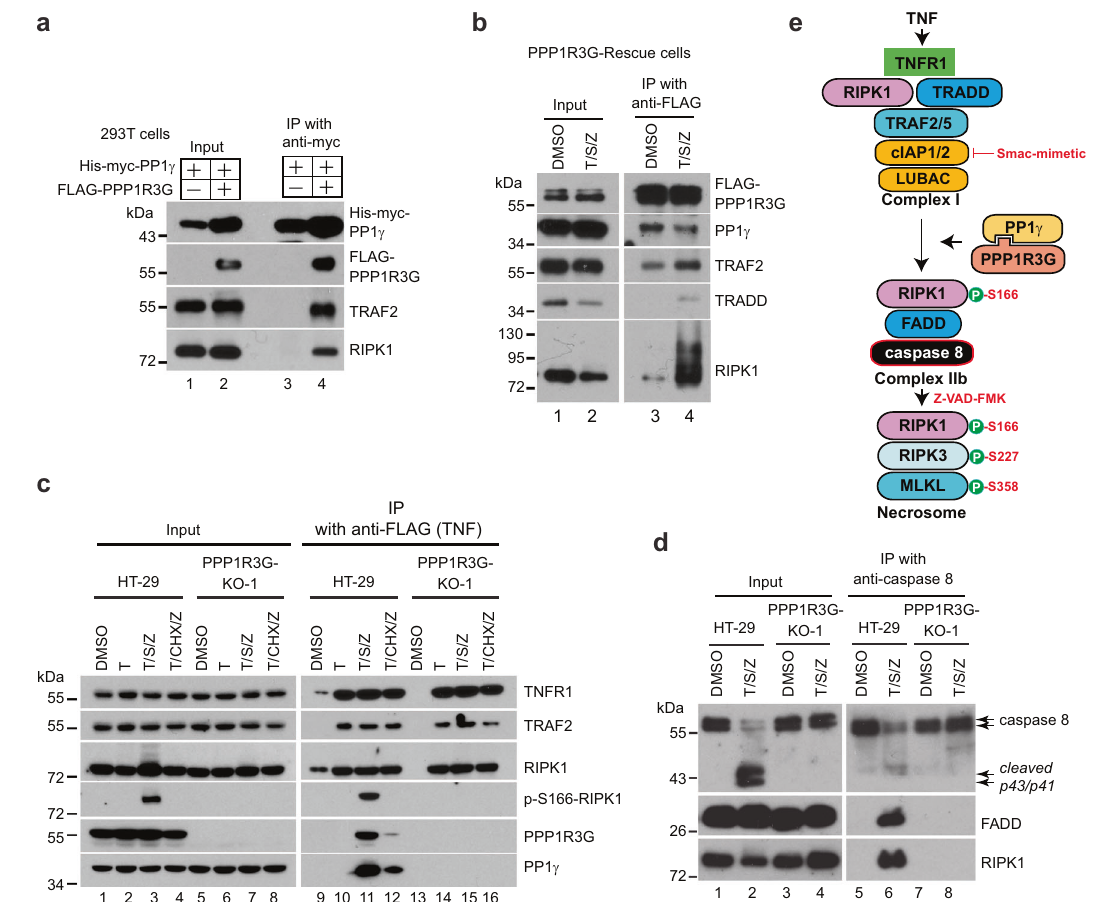
Fig. 4 PPP1R3G/PP1 γ interacts with complex I and is required for complex IIb formation. a 3xFLAG-tagged PPP1R3G and 12xHis-3xmyc-tagged PP1 γ were overexpressed in 293T cells, and cell lysates were subjected to anti-myc IP. Western blotting was performed with antibodies against myc, FLAG, TRAF2, and RIPK1. b PPP1R3G-Rescue cells were treated with DMSO or T/S/Z for 4 h. Cell lysates were subjected to anti-FLAG IP and Western blotting was performed with indicated antibodies. c HT-29 and PPP1R3G-KO-1 cells were treated with FLAG-TNF, FLAG-TNF/S/Z, or FLAG-TNF/CHX/Z for 1 h. Cell lysates were subjected to precipitation with anti-FLAG beads. Input and beads-associated proteins were subjected to Western botting with the indicated antibodies. d HT-29 and PPP1R3G-KO-1 cells were treated with T/S/Z for 4 h. Cell lysates were subjected to anti-caspase 8 IP. Western blotting was performed with indicated antibodies. Arrows denote full-length and cleaved caspase 8. Z-VAD-FMK inhibits activated caspase 8 but does not block caspase 8 self-cleavage. e Working hypothesis. TNF induces complex I formation. Co-treatment of Smac-mimetic leads to recruitment of PPP1R3G and PP1 γ to complex I, which is required for RIPK1 kinase activation and subsequent complex IIb formation. IP experiments in a – d were repeated at least twice and representative images were